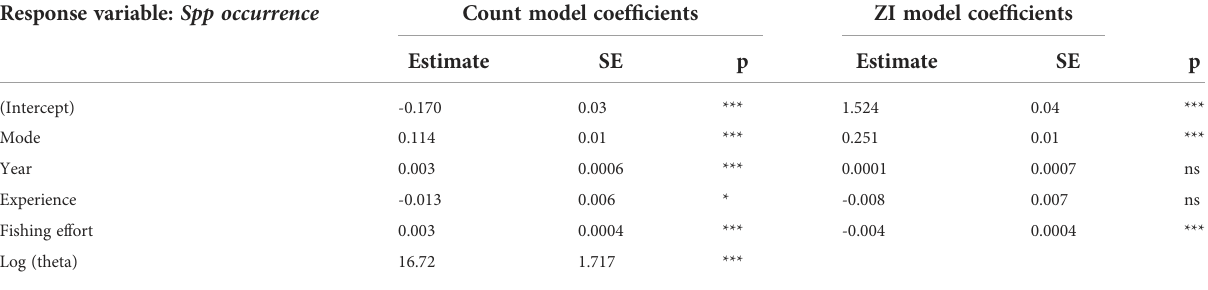
TABLE 2 Summary statistics of the zero in fl ated negative binomial model fi tted to species occurrence compositional data as response